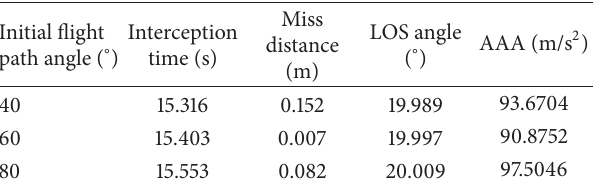
Figure 31: Sliding mode manifold (Case 3). Table 8: Summary of simulation results with different initial flight path